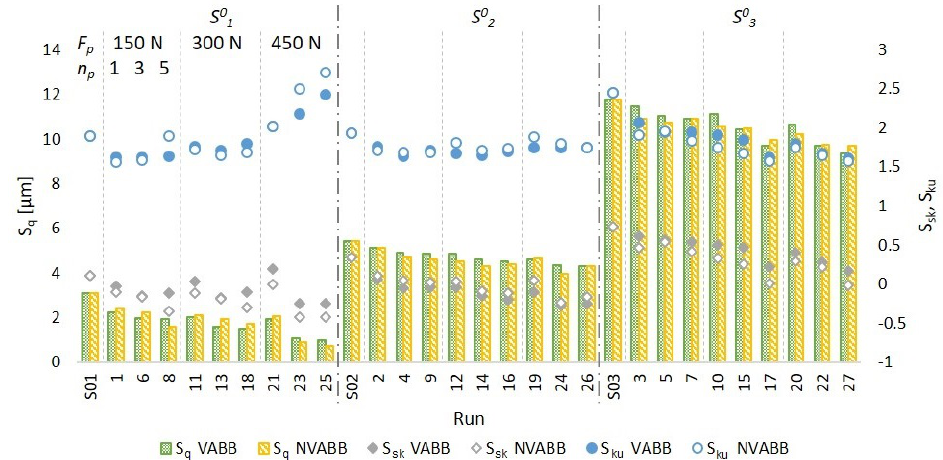
Figure 9. Comparison of S q , S sk and S ku parameters obtained after VABB and NVABB